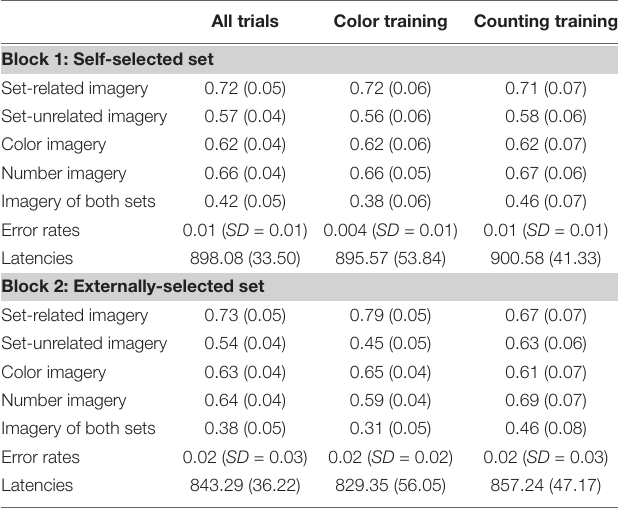
TABLE 1 | Mean Latencies (ms), proportions of imagery, and error rates as a function of block and training (Experiment